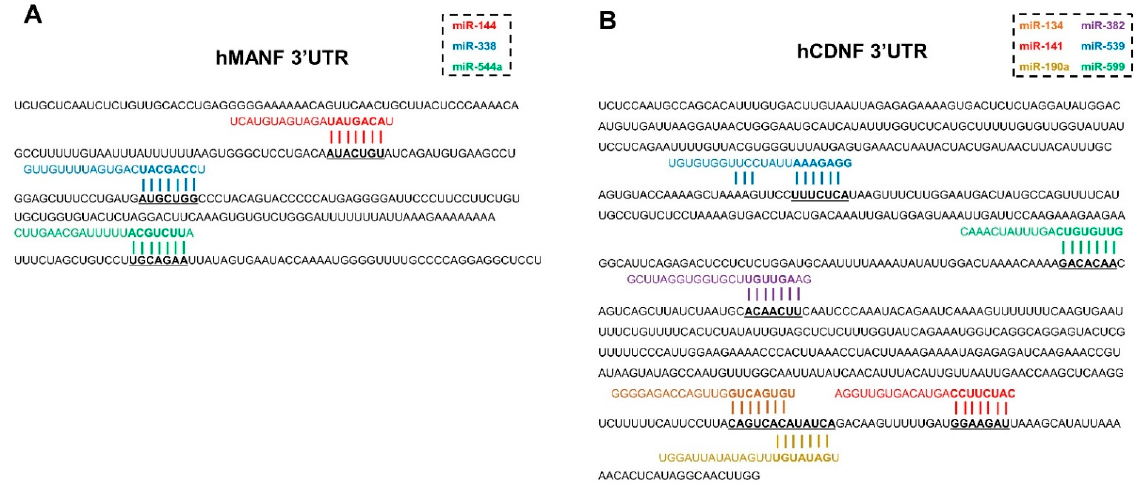
Figure 2. miRNAs predicted to target 3 ′ UTRs of ( A ) hMANF and ( B ) hCDNF. Only miRNAs, included in the current study, are shown. Alignment is adapted from TargetScan and miRanda.